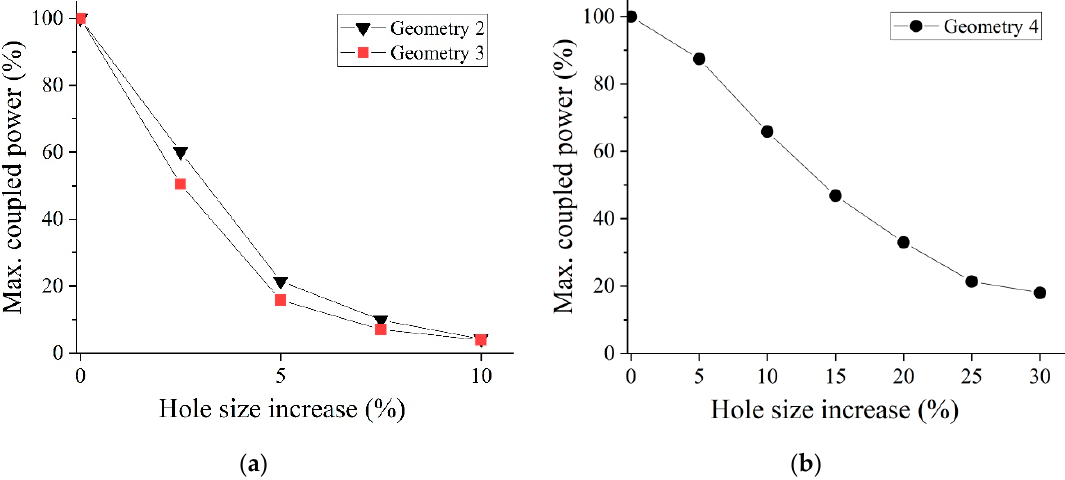
Figure 7. Percentage of coupled power versus radius increase of the selected holes in ( a ) Geometries 2 and 3, and ( b ) Geometry 4.